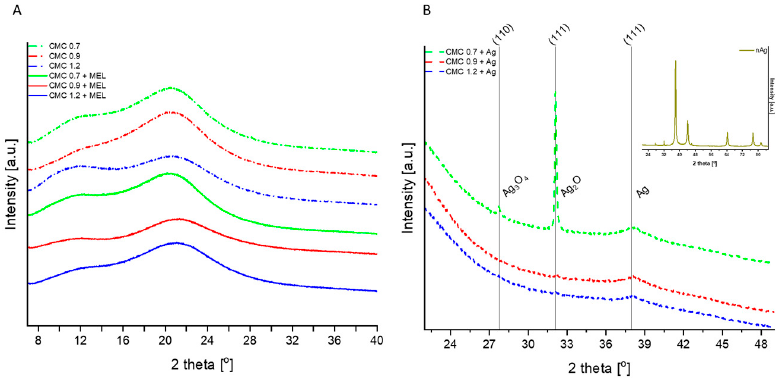
Figure 6 . XRD patterns of CMC X and CMC X + MEL, where X is the degree of substitution ( A ), CMC X + Ag and inset of Ag nanoparticles ( B